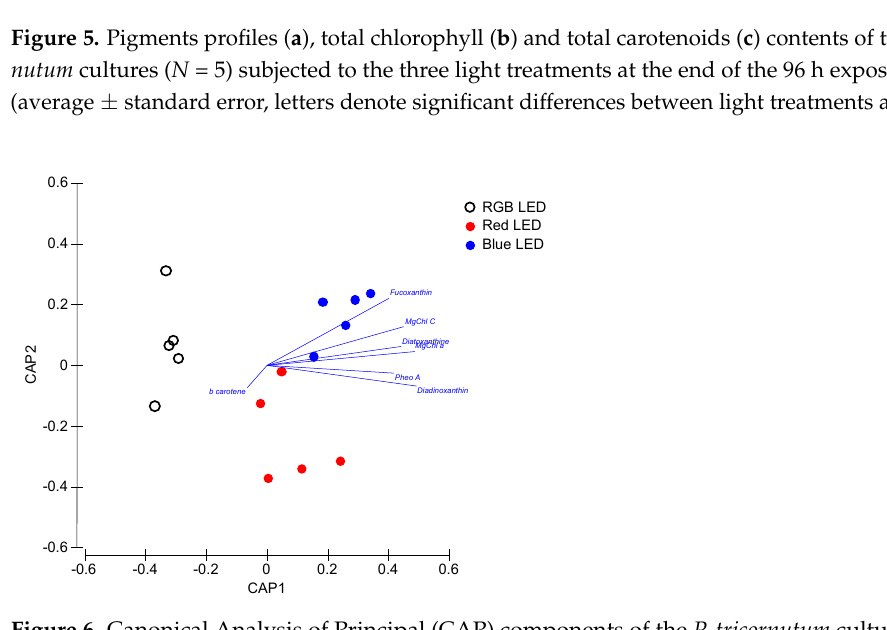
Figure 6. Canonical Analysis of Principal (CAP) components of the P. tricornutum cultures ( N = 5) subjected to the three light treatments, having as basis the full pigment profile at the end of the 96 h exposure period (93.3% classification efficiency).